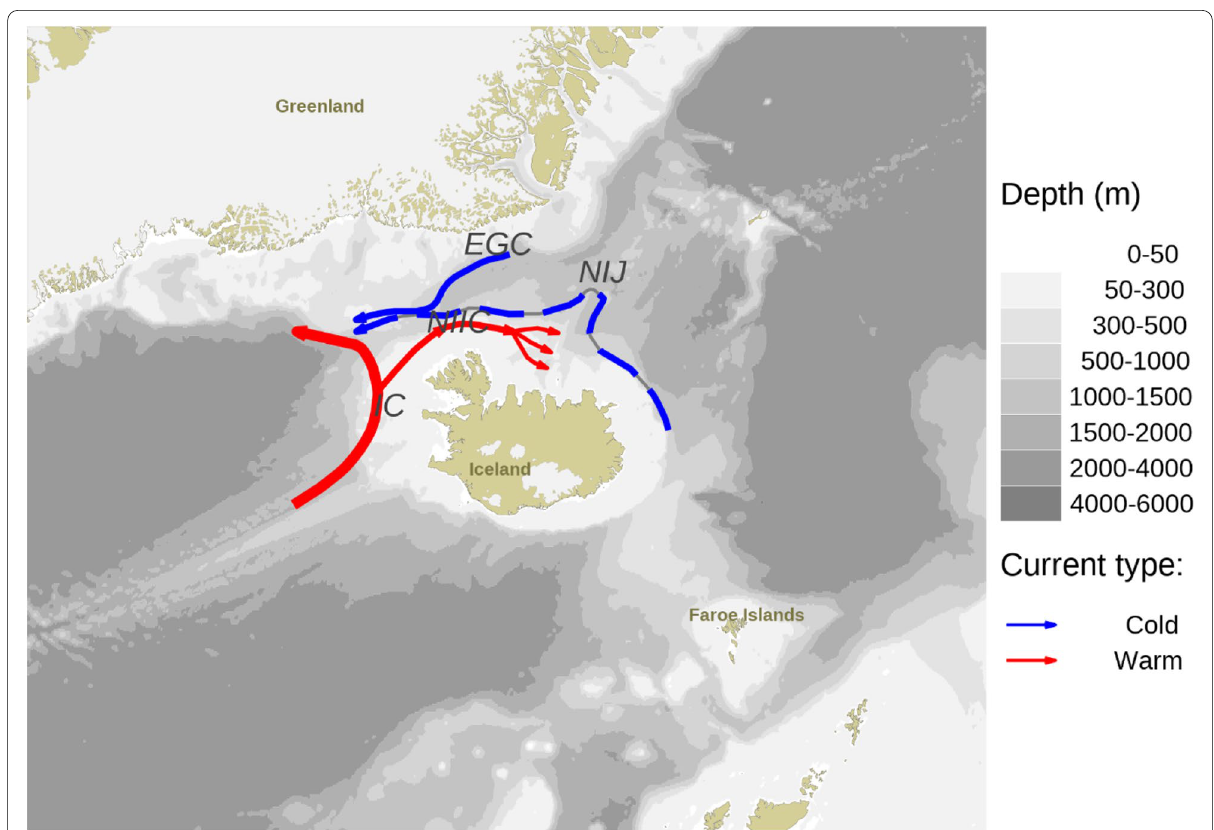
Fig. 2 The North Icelandic Irminger Current is a continuation of the Gulf Stream. It branches off and flows to the north of Iceland where it divides further and interacts with coastal and polar water. Abbrevations: EGC—East Greenland Current, IC—Irminger Current, NIIC—North Icelandic Irminger Current, NIJ—North Icelandic Jet. Solid lines: surface currents, dotted lines: deep currents. The map was produced with “ggOceanMaps” [184] by using [123] for ocean